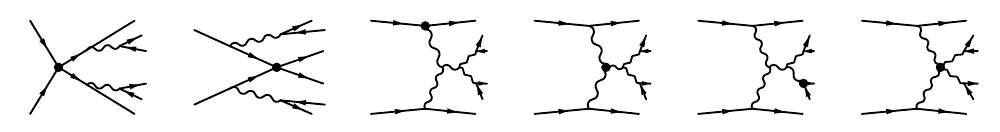
Figure 3 . Contributions to (cid:22)